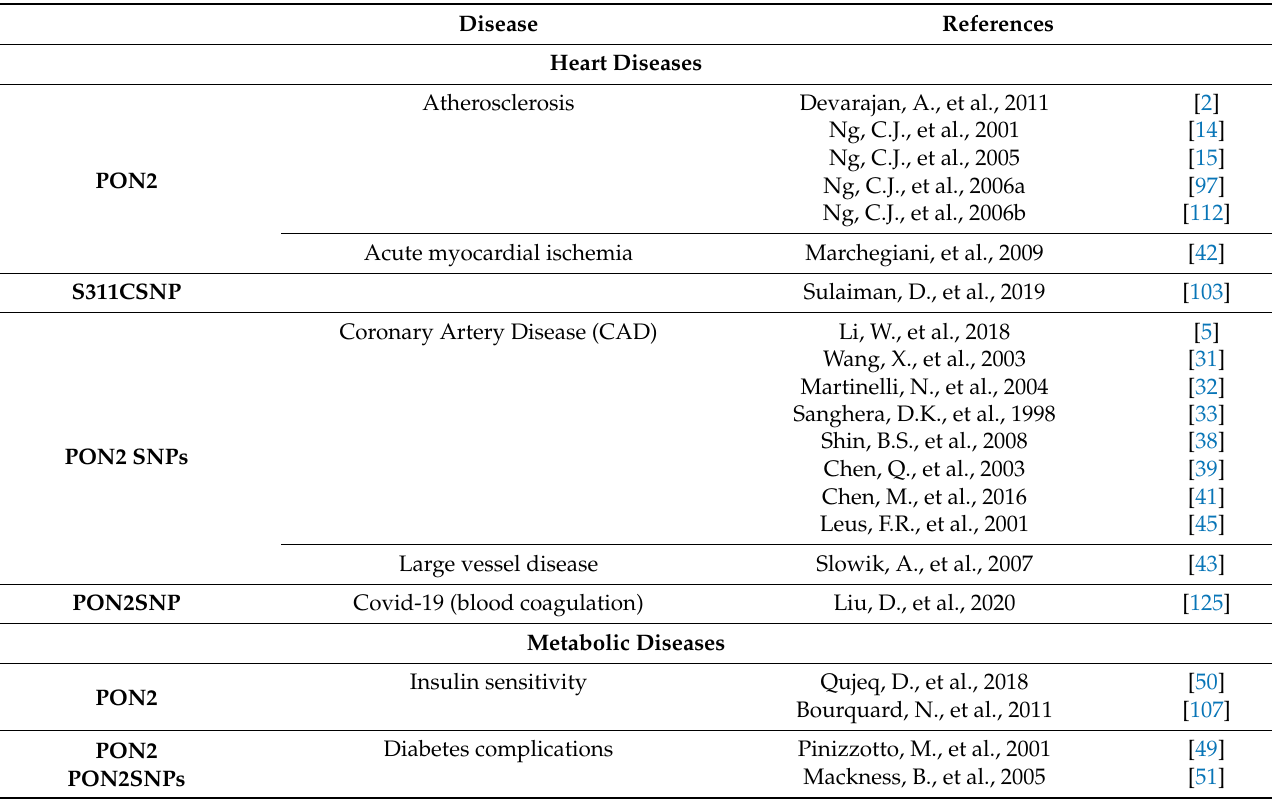
Table 1. PON2 and related human